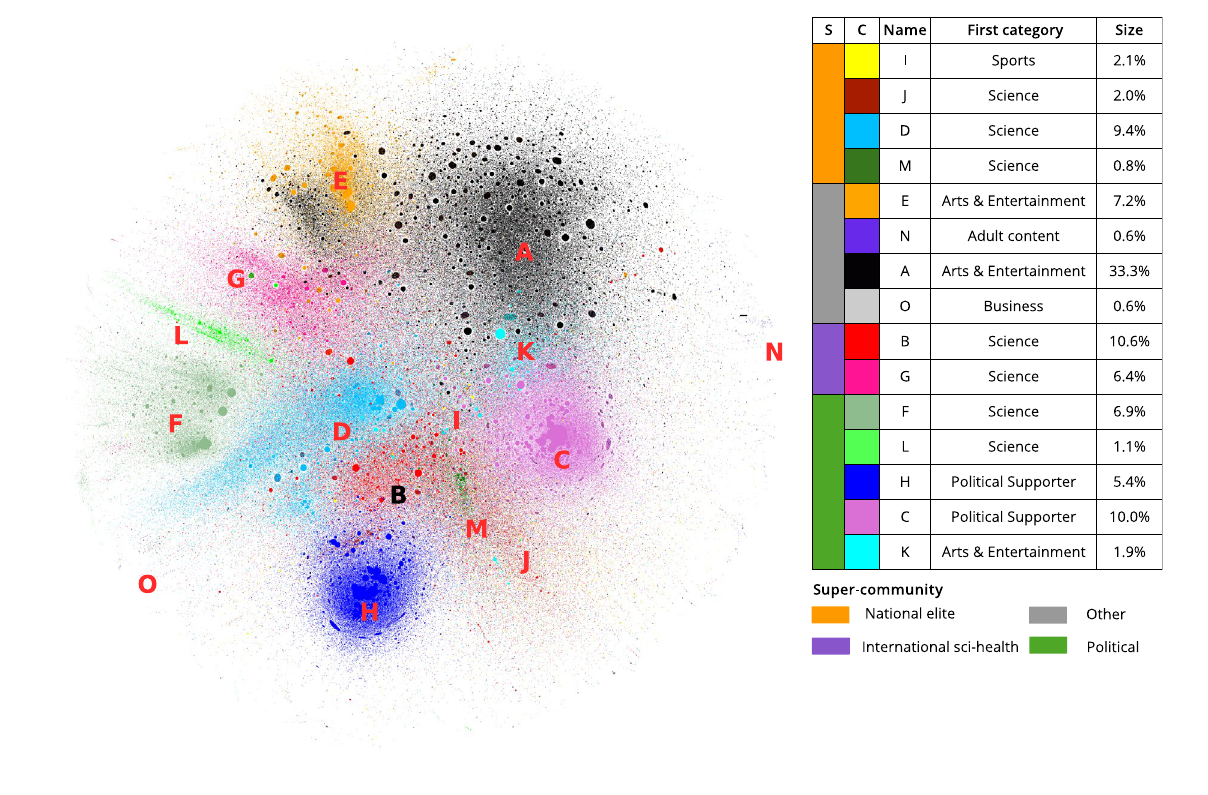
Figure 1. Retweet network of a randomly sampled connected component of 1M users, colored by community. Node size is proportional to node out-degree. In the table, the column “S” designates the color of the super- communities used throughout this work, “C” lists the community color in the network layout and “Name” the respective community name. The “Dominant category” column specifies the most abundant user category in the community (excluding “Other”). “Size” denotes the ratio of users in the community with respect to the total number of users in the network.